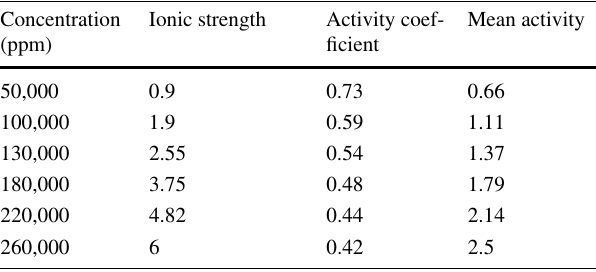
Table 6 Data related to calculation of surface excess concentration